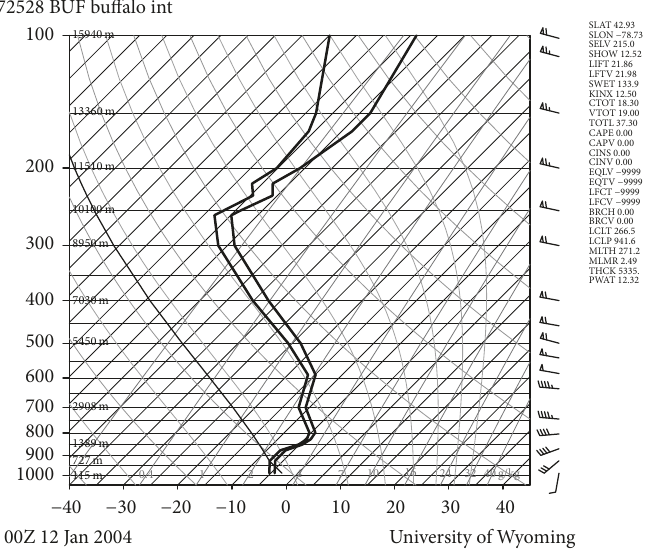
Figure 9: Skew- 𝑇 log 𝑝 thermodynamic diagram of temperature (solid right, ∘ C) and dew point (solid left, ∘ C), based on radiosonde observations from Buffalo, NY (KBUF), valid at 0000 UTC 12 January 2004. Wind barbs are in standard plotting convention (flag = 25 m s −1 , full feather = 5 ms −1 , half feather = 2.5 ms −1 ). Diagram courtesy of University of Wyoming.